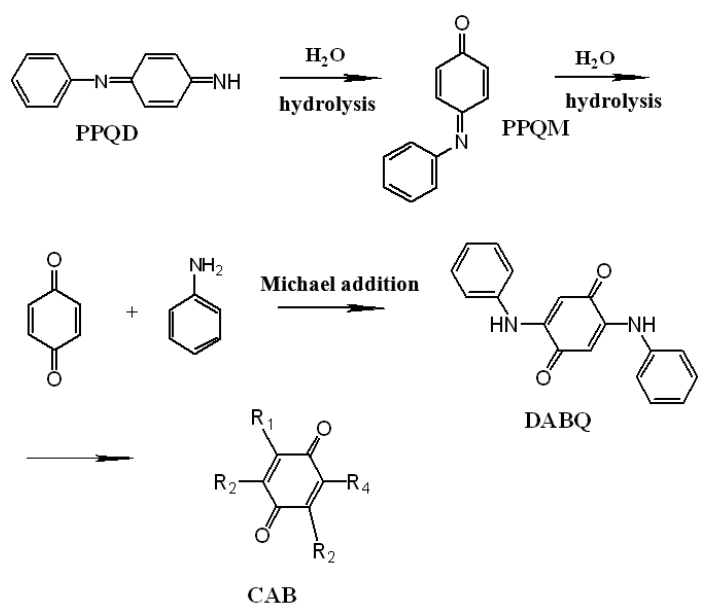
Scheme 2. Side reactions in the polymerization of aniline, R1, R2, R3, R4 = H, N -phenylamino group, etc. [32].